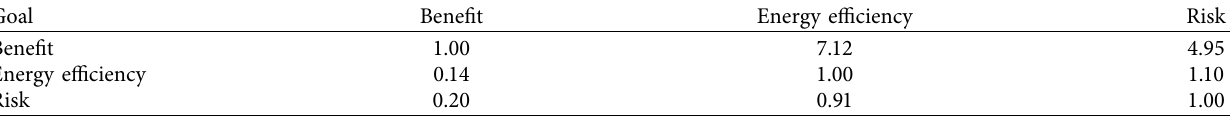
Table 2: Criteria layer comparison value list of the rural land circulation mode performance evaluation.